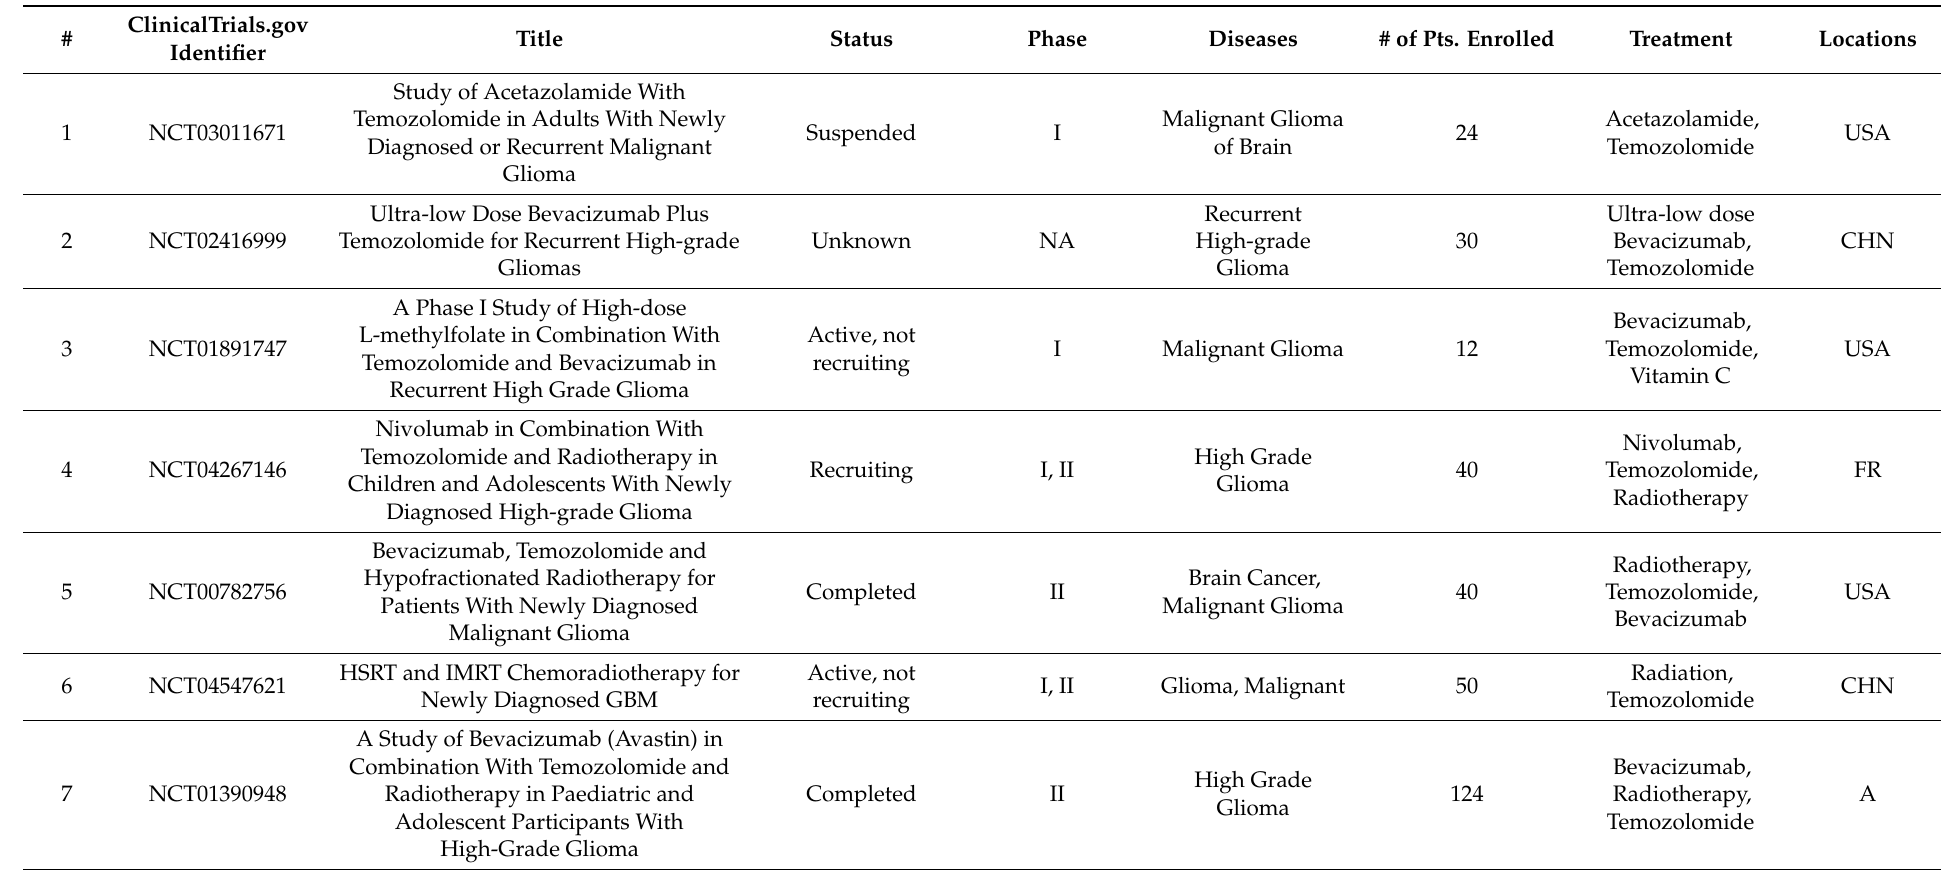
Table 2. Main clinical trials on immunotherapies for high-grade